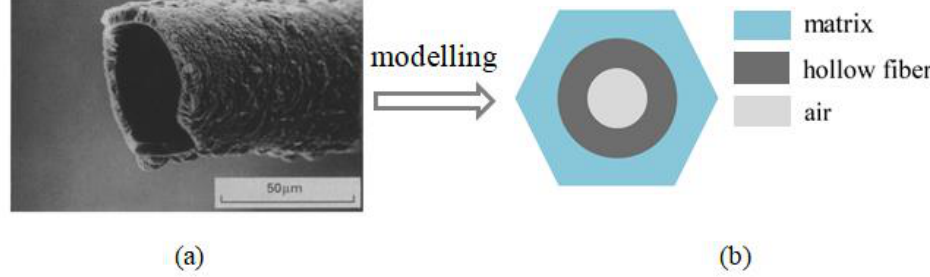
Figure 3. ( a ) SEM images of a hollow fiber (reprinted with permission from Ref. [4]. Copyright 1994 Elsevier) and ( b ) the corresponding RVE 2 model with matrix, fiber phase and